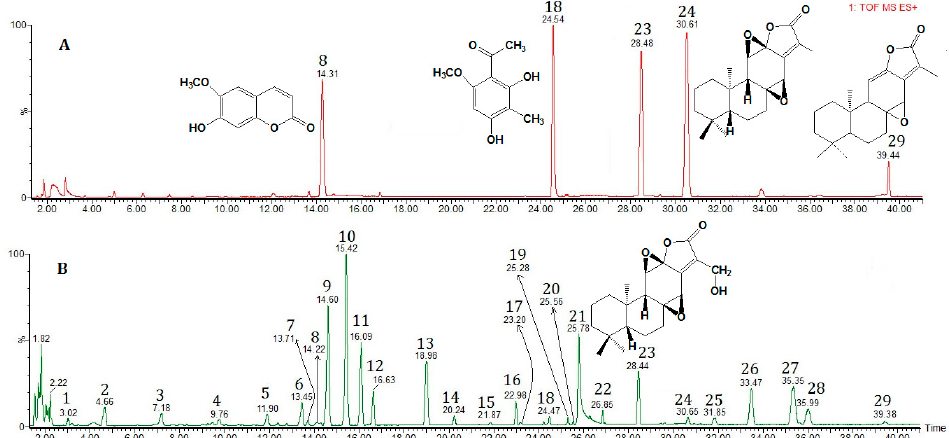
Figure 4. Representative ultra-performance liquid chromatography coupled with the quadrupole time-of-flight tandem mass spectrometry (UPLC-Q-TOF-MS) chromatograms of: ( A ) Total ion chromatogram (TIC) of reference stock solution ( 8 , Scopoletin; 18 , 2,4-Dihydroxy-6-methoxy-3-methylacetophen one; 23 , 17-Hydroxyjolkinolide B; 24 , Jolkinolide B; and 29 , Jolkinolide A); and ( B ) TIC of extract sample obtained from Euphorbia fischeriana in positive-ion